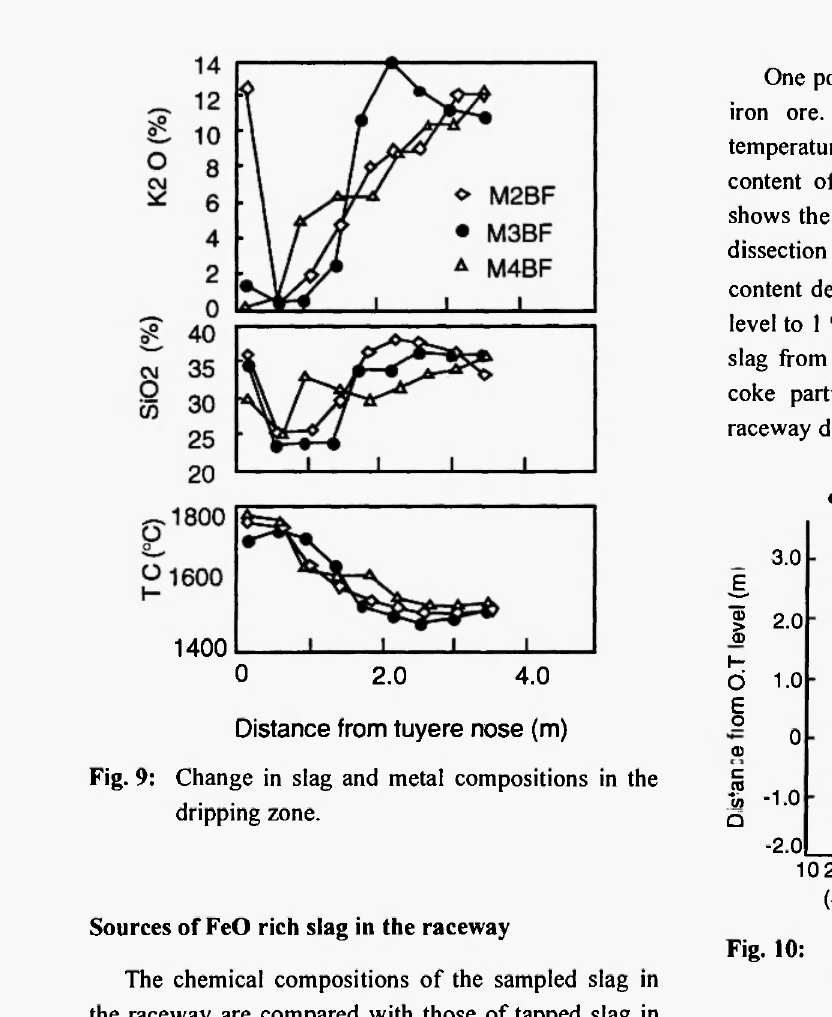
Change in slag and metal composition in the dripping zone (Chiba No. 1 blast furnace). The oxygen pressure